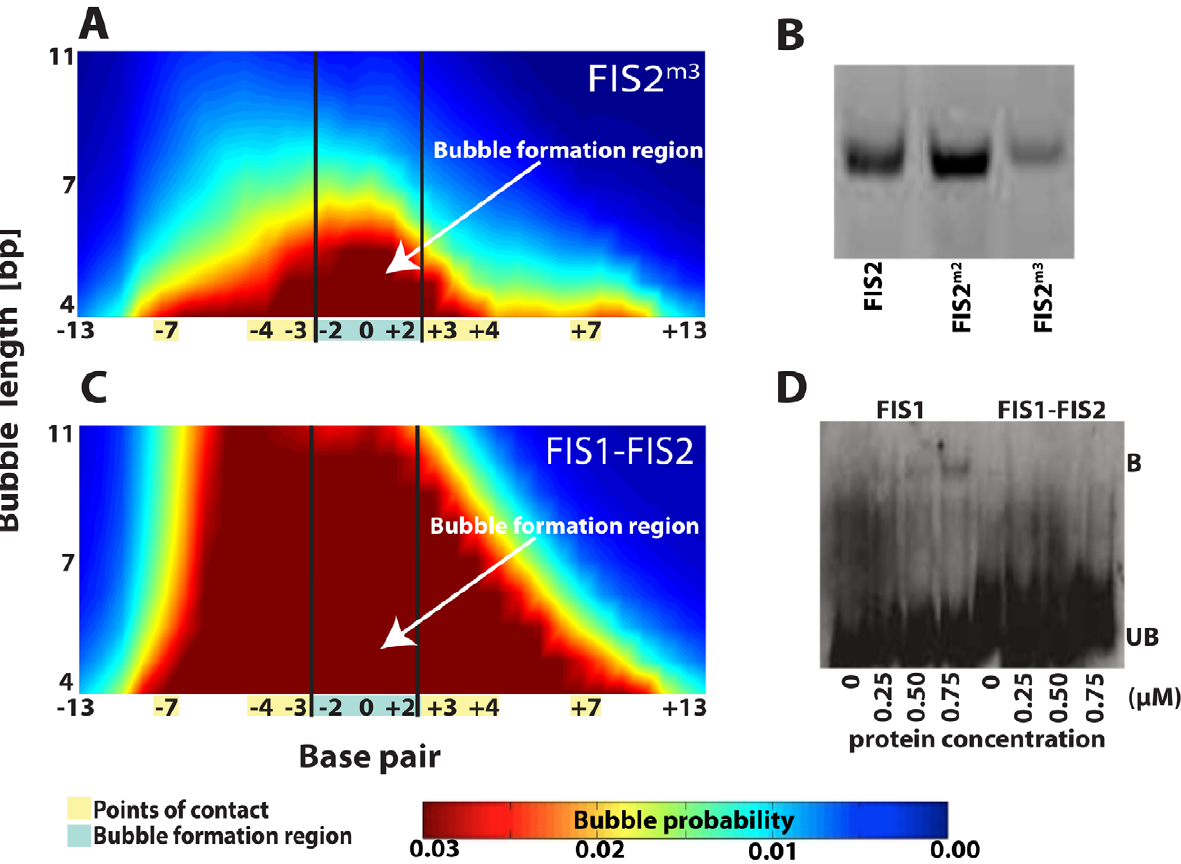
Figure 6. Fis binding site modifications, Langevin dynamics simulations of DNA breathing, and EMSA experiments, the second set. (A) Langevin dynamics simulations reinforcing the local DNA breathing dynamics in FIS2 m3 via three O6-methylguanine modifications in the bubble formation region of FIS2 (Table 1). The direct points-of-contacts remain unchanged. (B) Polyacrylamide gel electrophoresis of dsDNA oligonucleotides sequences - FIS2, FIS2 m2 , and FIS2 m3 - demonstrating gel migratory effects due to possible bubble formation (gel at 15%). (C) Langevin dynamics simulations demonstrating local disruption of the hydrogen bonds in the super-enhanced DNA local openings of the FIS1–FIS2 sequence (Table 1) caused by the presence of five mismatches at the FIS1 bubble formation region. (D) EMSA demonstrating the lack in complex formation in FIS1–FIS2. Concentration of the FIS1 and FIS1–FIS2 oligomers were constant at 100 nM and Fis protein ranged from 0 to 0.75 m M. Sonicated salmon sperm DNA at 0.5–1 m g/ m l was added to the binding reactions to eliminate non-specific binding. In Langevin dynamics simulations (panels A and C) the probability of bubble openings is represented by the same color map as in Figure 5; red denotes high probability and blue denotes low probability of opening. The probability is determined from the lifetimes of all open states with a given length (bp) and above amplitude of 1.0 (A˚), normalized over the complete time of the simulation. The length of the transient bubbles, given in base pairs [bp], is shown along the vertical axis. The horizontal axis depicts base pair position; the bubble formation region is highlighted in blue while the points-of-contact are highlighted in yellow. The names of each of the sequences are shown in the panels while the complete nucleotide sequences could be found in Table 1.